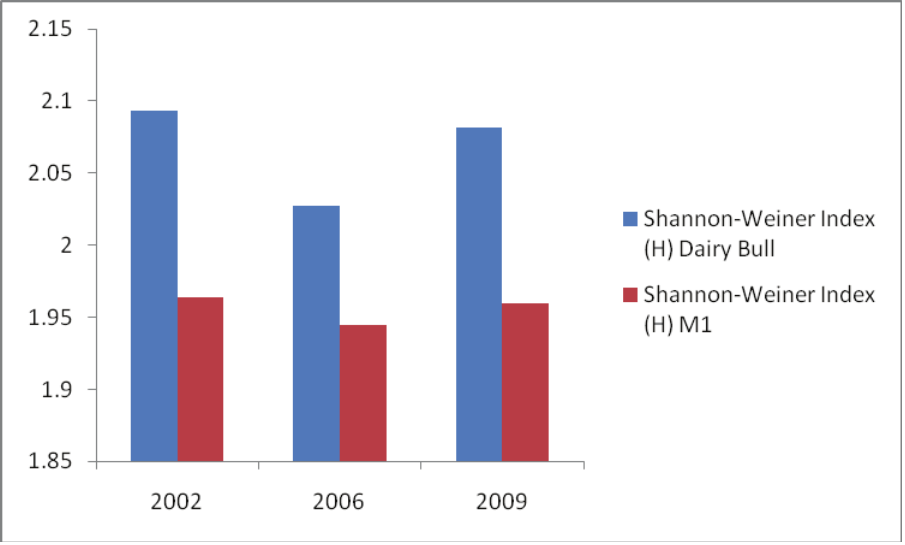
Figure 5. Shannon-Weiner Biodiversity Indices for Dairy Bull and M1 reef sites, in 2002, 2006 and